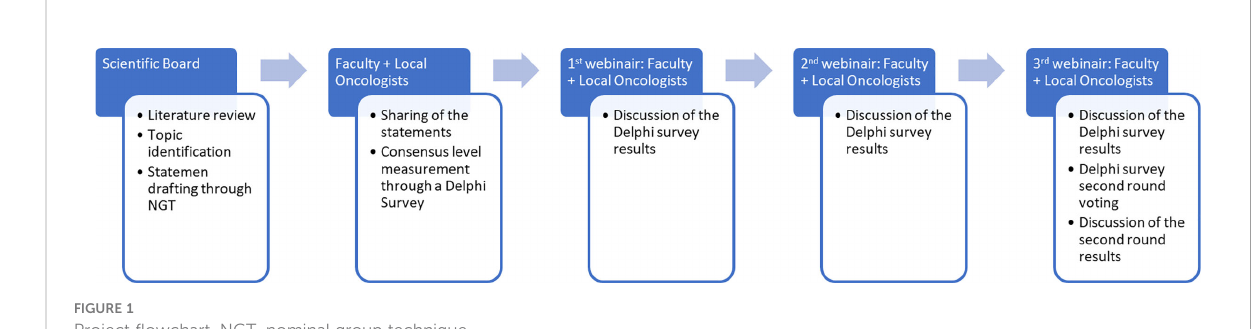
FIGURE 1 Project fl owchart. NGT, nominal group